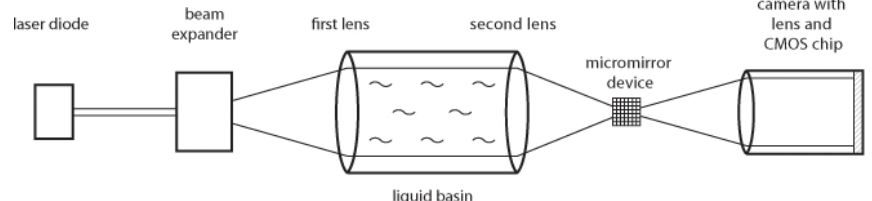
Figure 11. Measurement setup of the optical Schlieren system.